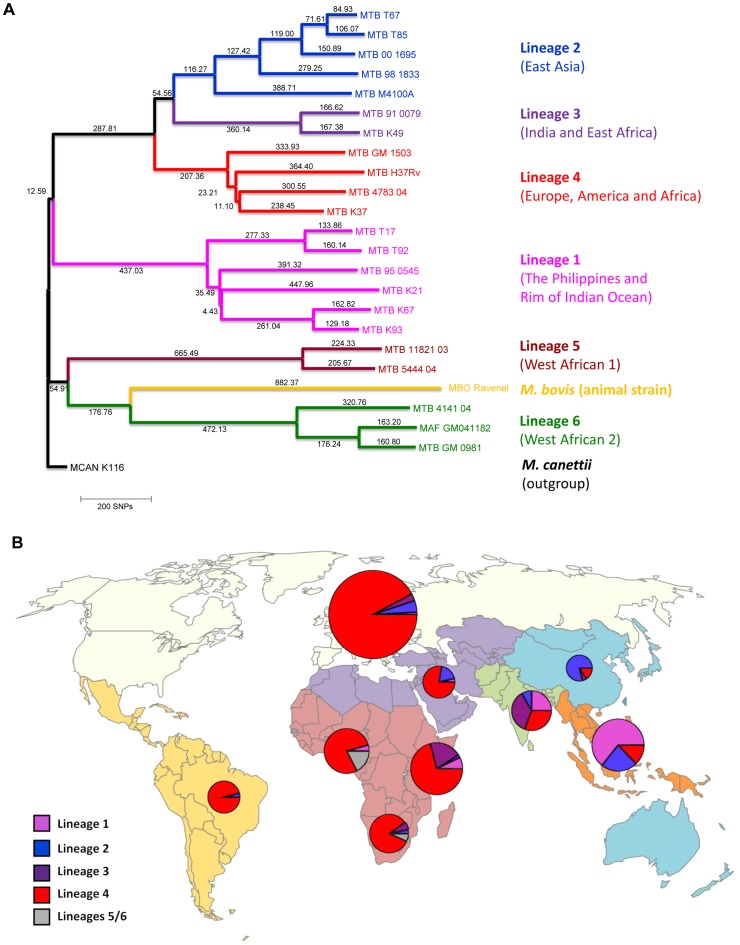
Phylogeography of the six main Mycobacterium tuberculosis lineages.A: Phylogenetic tree of the main M. tuberculosis lineages described in our study based on the neighbor-joining phylogeny across 23 M. tuberculosis complex whole-genome sequences (from Ref. [72]). Numbers on branches refer to the corresponding number of single nucleotide polymorphisms inferred. B: Distribution of the main phylogenetic M. tuberculosis lineages among Swiss tuberculosis cases included in the study (n = 518), by geographic origin of the patients. In (A) Mycobacterium canettii was used as the outgroup. SNPs, single nucleotide polymorphisms. In (B) the sizes of the pie charts correspond to the number of patients included in the study: European region (233 patients), Middle-East/North Africa (27), Indian subcontinent (36), Western Pacific (19), Central/South America (24), South-East Asia (48), and Eastern (55), Western (46) and Southern region (30) of sub-Saharan Africa. Lineage 1: Indo-Oceanic lineage; Lineage 2: East-Asian lineage (includes Beijing strains); Lineage 3: Delhi/CAS; Lineage 4: Euro-American lineage; Lineages 5 and 6: West African lineages.